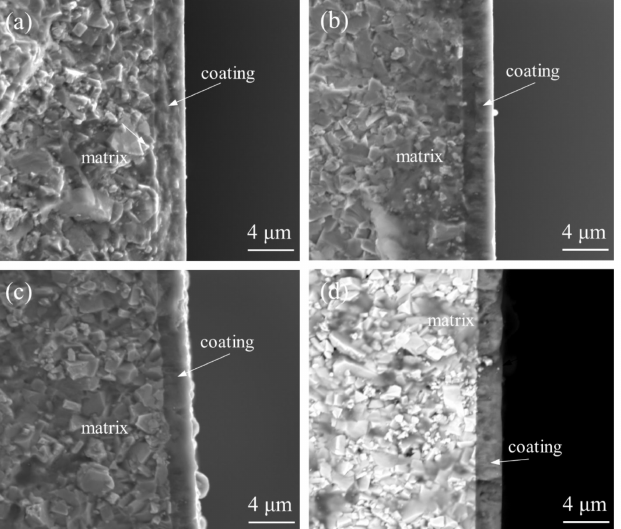
Figure 4. Cross-sectional morphology of the coatings at different bias voltages: ( a ) − 60 V; ( b ) − 80 V; ( c ) − 100 V; ( d ) − 120 V.